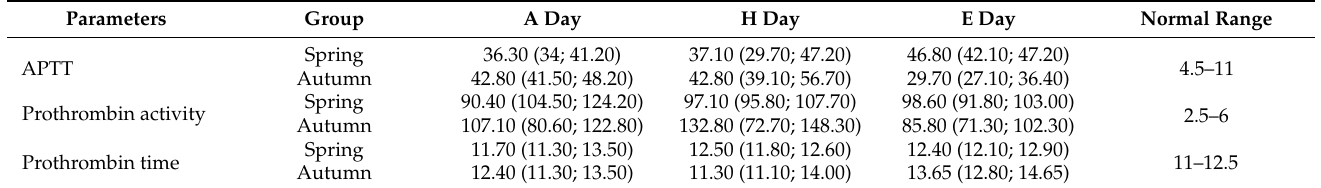
Table 7. Abnormal and normal values of coagulation factors’ count in the two groups on three specific days in the ICU—Brixia A, H and E: median values and interquartile range.